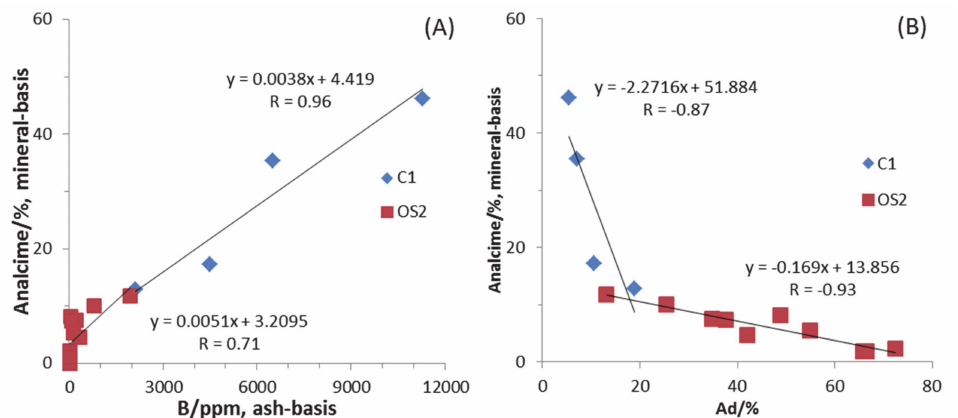
Figure 13. Relationships between B and ash yield with analcime in C1 coals and OS2 oil shales. ( A ) analcime on mineral basis vs. B on ash basis; ( B ) analcime on mineral basis vs. ash yield on a dry